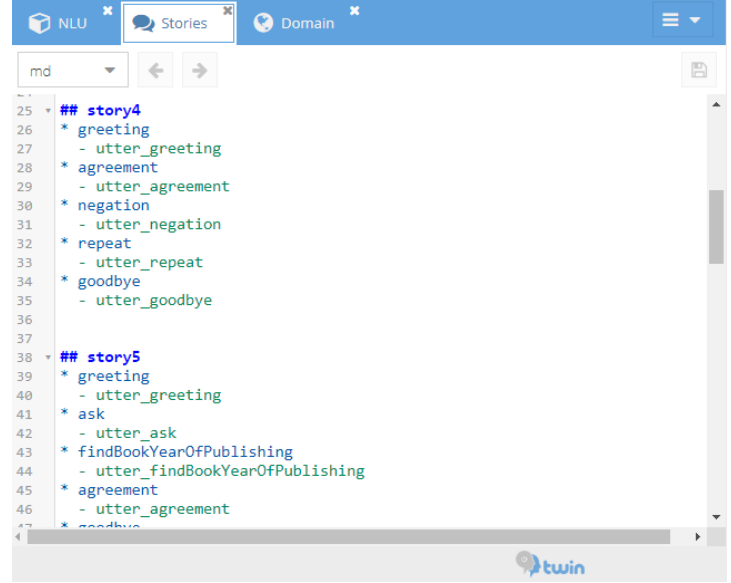
Fig. 6. Examples for the interactive